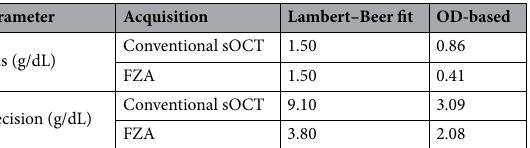
Table 1. Comparison of the precision and bias obtained for multiple sOCT-based [tHb] estimations.